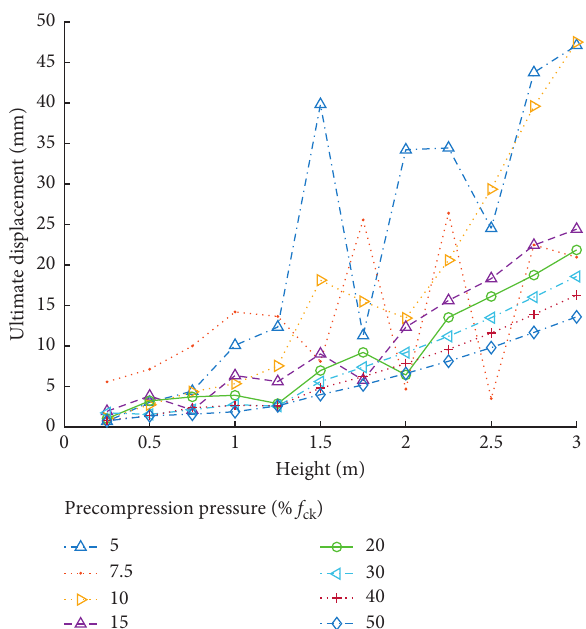
Figure 5: Ultimate force vs height plot for different pre- compression ratios.